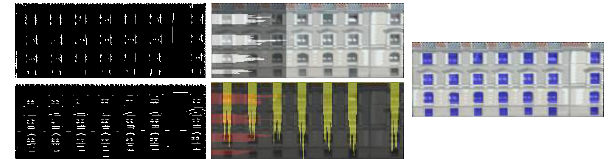
Figure 2: Processing steps for floor and window detection. (a) Horizontal and vertical edges, (b) maxima search in horizontal projection profile and overlay of the two profiles, (c) result of the window detection with highlighted window locations in blue. The count of floors and windows coincides with ground truth.